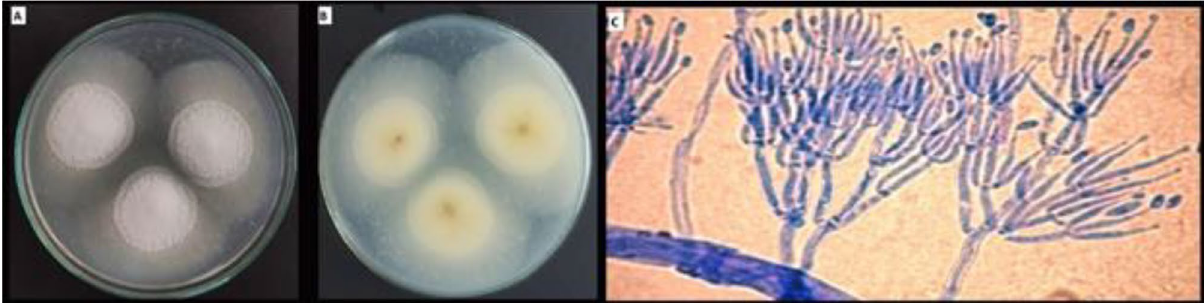
Figure 6. Cultural and morphological characteristics of the bioagent, Clonostachys rosea ; isolate AUMC15121 of healthy lucky bamboo ( D. sanderiana ) plants: Colony on PDA after seven days, ( A ) top surface, ( B ) lower surface, and ( C ) conidiophores and